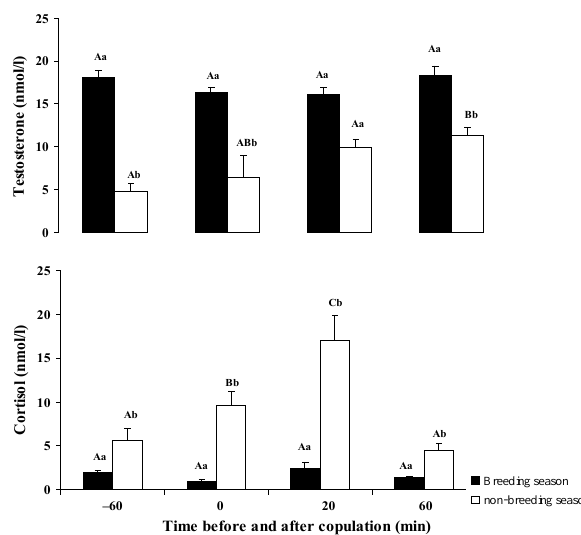
Figure 3. Mean ( ± SEM) plasma testosterone and cortisol level prior to and following copulation process during breeding and non- breeding season. Values for each hormone with different letters within breeding and within non-breeding season (ABC) signifi- cantly differ ( P< 0 . 05). Values for each hormone with different let- ters between seasons (ab) significantly differ ( P< 0 .